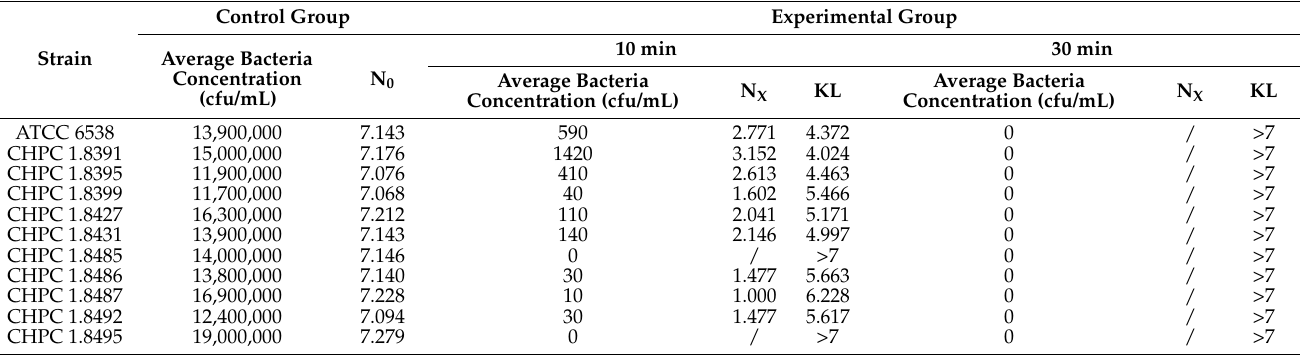
Table 3. Quantitative germicidal test